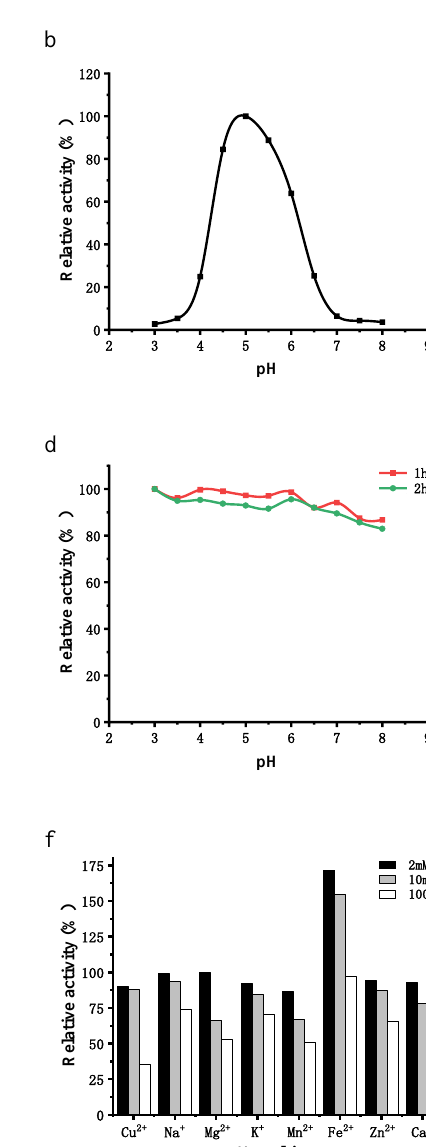
Figure 2. Electrophoretic analysis of α -galactosidase ( a ) 8% SDS-PAGE: Lane 1: Protein marker; Lane 2: Crude enzyme; and Lane 3: Purified enzyme; ( b ) 8% Native-PAGE: Lane 1: Crude enzyme; Lane 2: Purified enzyme; and Lane 3: Purified enzyme after concentration; ( c ) 8% Native-PAGE (similar to ( b )).